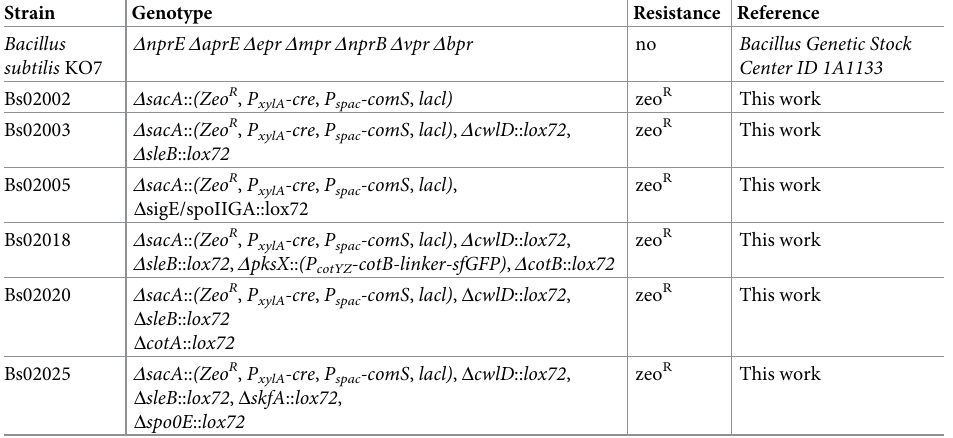
Table 1. List of strains used in the present study. Strain Genotype on the surface of the spores, was constructed by fusing the sequence of sfgfp in frame to the C-terminal coding end of the gene cotB . The two genes were bridged by a linker made of 12 amino acids. The fusion gene was integrated into the pksX locus via homologous recombi- nation and was expressed under the control of P cotYZ promoter ( pksX :: PcotYZ-cotB- linker-sfgfp) . The native cotB gene was deleted from the genome of strain Bs02018 [28]. Strain Bs02020 harbors additionally deletion of cotA [29] gene whereas strain Bs02025 har- bors deletion of skfA [30] and spo0E [31] genes. All strains employed in this work were gen- erated by transformation of B . subtilis with non-replicative plasmid DNA as described previously [32]. Plasmid construction for B . subtilis deletion strains. The P cotYZ promoter (108 bp) was amplified using B . subtilis KO7 genome as template and oligonucleotides 02124 and 02171 (S1 Table). DNA coding for cotB gene (1,140 bp) was amplified using B . subtilis KO7 genomic DNA and oligonucleotides pair 02172 and 02173 (S1 Table) encoding for CotB and a flexible linker (2 repeats of Gly-Gly-Gly-Gly-Gly-Ser) located at the C-terminal end of CotB. The sfgfp gene (717 bp) was amplified from the plasmid pYTK001 (www.addgene.org, plasmid: PYTK001) using the oligonucleotides 02066 and 02067 (S1 Table). The plasmid vector con- taining two homology regions for integration in the pksX locus and the spectinomycin resis- tance cassette, was amplified using plasmid pJK179 as template and oligonucleotides 31055 and 02017 (S1 Table). The PCR products amplified using plasmid template, were digested with DpnI (NEB, Ipswich, MA, USA) in order to reduce plasmid carry over. Plasmid assembly was performed using SLiCE as described by Messerschmidt and coworkers [33] using E . coli DH10B (NEB, Ipswich, MA, USA) as the shuttle host. Gene deletions in B . subtilis were conducted via double crossover. Flanking regions upstream and downstream of the gene of interest were PCR amplified using chromosomal DNA as template and the respective oligonucleotide pair (S1 Table). These PCR products, a spectinomycin resistance cassette [34] and a linearized pJET vector (Thermo Fisher Scientific) were assembled using the SLiCE method [33]. The resulting plasmids were isolated from E . coli , verified via sequencing and transformed without linearization into B . subtilis via natural competence as described previously [32]. A list of all plasmids used for deletions can be found in S2 Table whereas corresponding Genbank files are available in a public GitLab repository under https://gitlab.com/sporesort/.